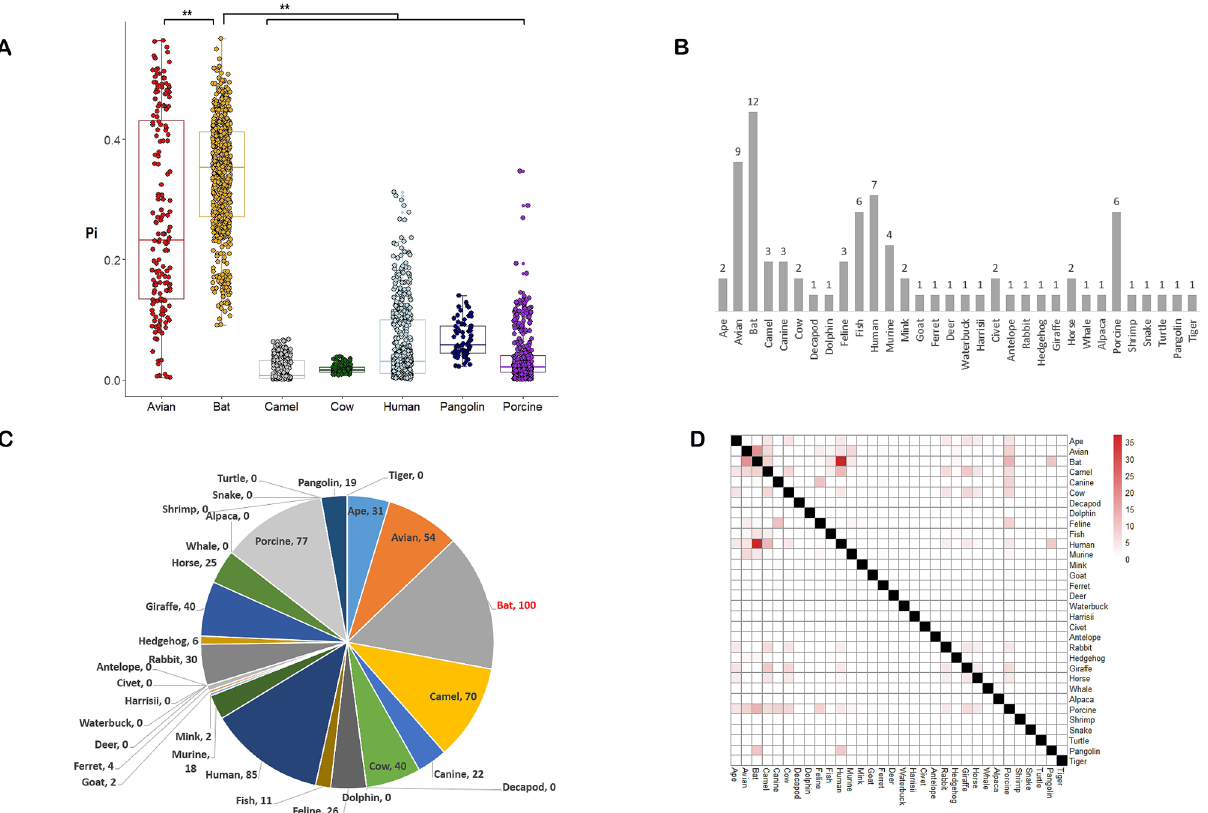
Figure 3. Evidence showing that bats may be a pool of genetic diversity. ( A ) Comparison of Pi in the nearby region of RI_RNA_S for coronaviruses from 7 different hosts, such as bat, human and pangolin. Pi values were calculated through a sliding window approach in the region from 21,500 to 25,000 bp according to MN908947. ( B ) Numbers of subclades of coronavirus in different hosts. ( C ) ie chart showing the numbers of independent recombination events in different hosts. Bat harbored the highest number and is marked in red. ( D ) Heatmap showing the numbers of independent recombination events occurring in coronaviruses between pairs of hosts the x and y axes). We did not consider recombination events between coronaviruses from the same host, which are marked by black